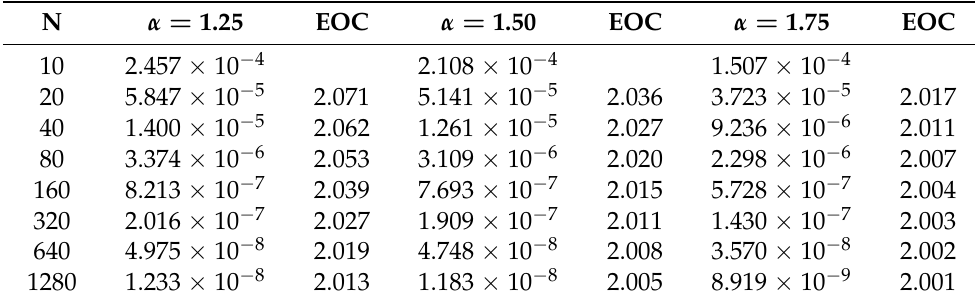
Table 7. Table showing the maximum absolute error and EOC for solving Example 3 using the predictor–corrector method for α >